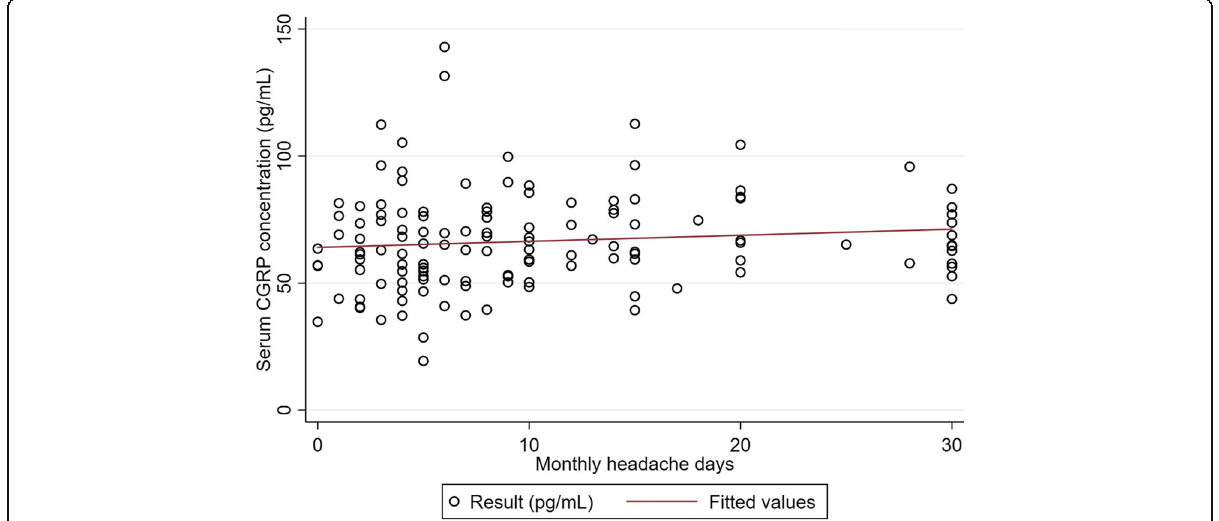
Fig. 2 Scatterplot between interictal serum CGRP concentration and monthly headache days in all patients with migraine